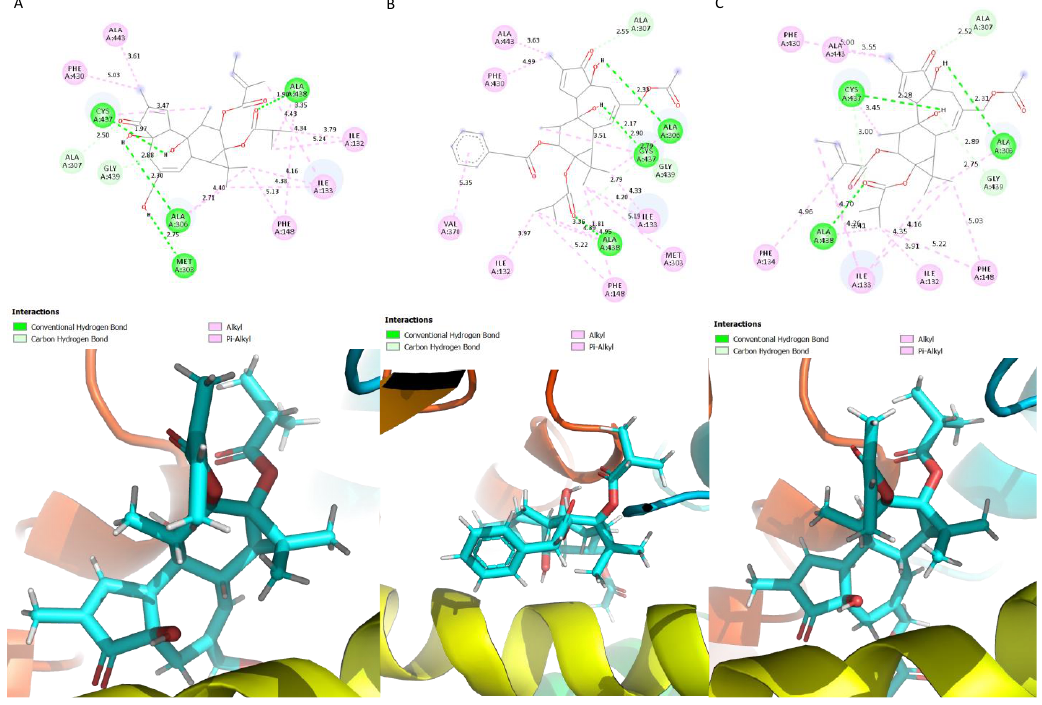
Figure 3. Schematic showing the protein ligand interactions ( A ) P-12Ang-13iBu ( B ) P-20Ac-12AcPh- 13iBu ( C ) P-20Ac-12Ang-13iBu. The aromatase inhibitor anastrozole interacted with mostly non-polar residues with the exception of Tyr 220, Ser 478 and His 480, which were the only polar residues inter- acting with the ligand (Figure 4A). A carbon – hydrogen bond and pi-anion interaction was observed between the benzene ring of the ligand anastrozole and the amino acid residue Asp 309 (Figure 4A). Hydrogen bonds were formed between His 480 and Ser 478; the residues Trp 224 and Tyr 220 formed a pi – pi t-shaped interaction with the anastrozole (Figure 4A). Letrozole interacted with non-polar residues with the exception of Ser 314 (Figure 4B). Carbon – hydrogen bonds were formed with Thr 310 (a pi – pi t-shaped interac- tion was also formed) and Ser 314, and a Pi – sulphur interaction was formed with the lig- and Letrozole (Figure 4B). Phe 430 formed an amide – pi stacked interaction with the ligand (Figure 4B). The ligand exemestane interacted with only five residues: Ile 133, Ala 438, Arg 145, Cys 437 and Ile 132 (Figure 4C). The residue Arg 145 formed a hydrogen bond with the ligand exemestane; the other interacting residues formed alkyl interactions with the ligand. The findings of this study are in line with those of a previous study regarding the residues that were identified [33].